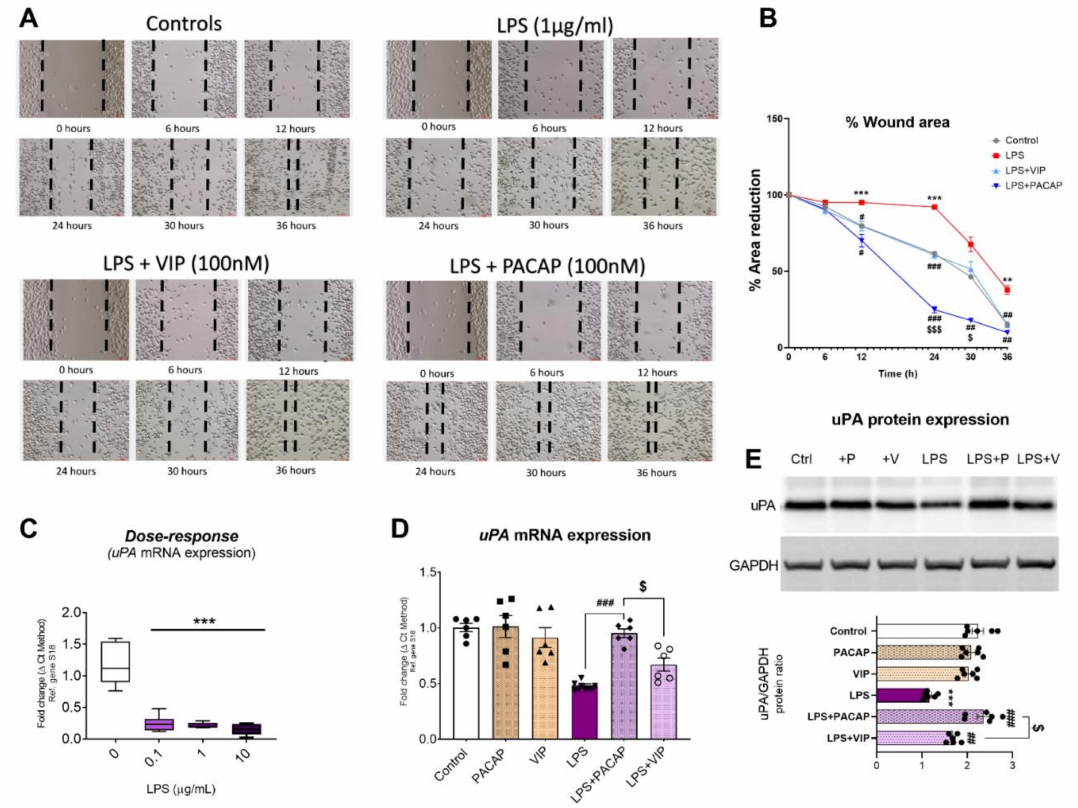
Figure 10. Effects of PACAP or VIP treatment on cell motility (wound healing assay) and uPA expression in LPS-treated BV2 cells. BV2 cells plated in 6-well plates and left to grow until 95% confluent in 1% FGM for 24 h prior to treatment with 10% FGM (control). A scratch was created in the centre of the well using a P1000 pipette tip and media replaced with indicated treatments: 10% FGM (control), 1.0 µ g/mL LPS, 1.0 µ g/mL LPS + PACAP 100 nM and 1.0 µ g/mL LPS + VIP 100 nM.